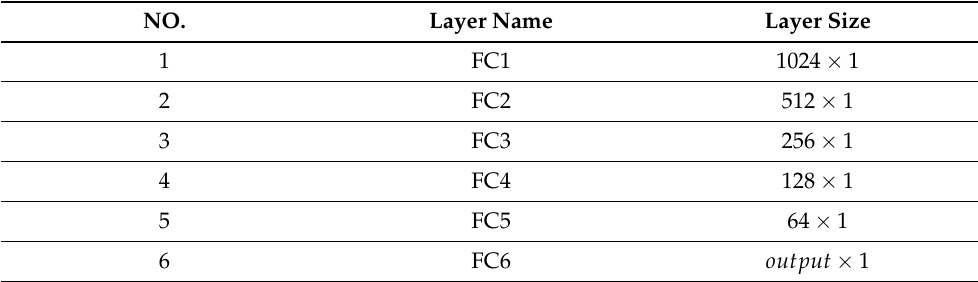
Table 3. Architecture-related hyperparameters of